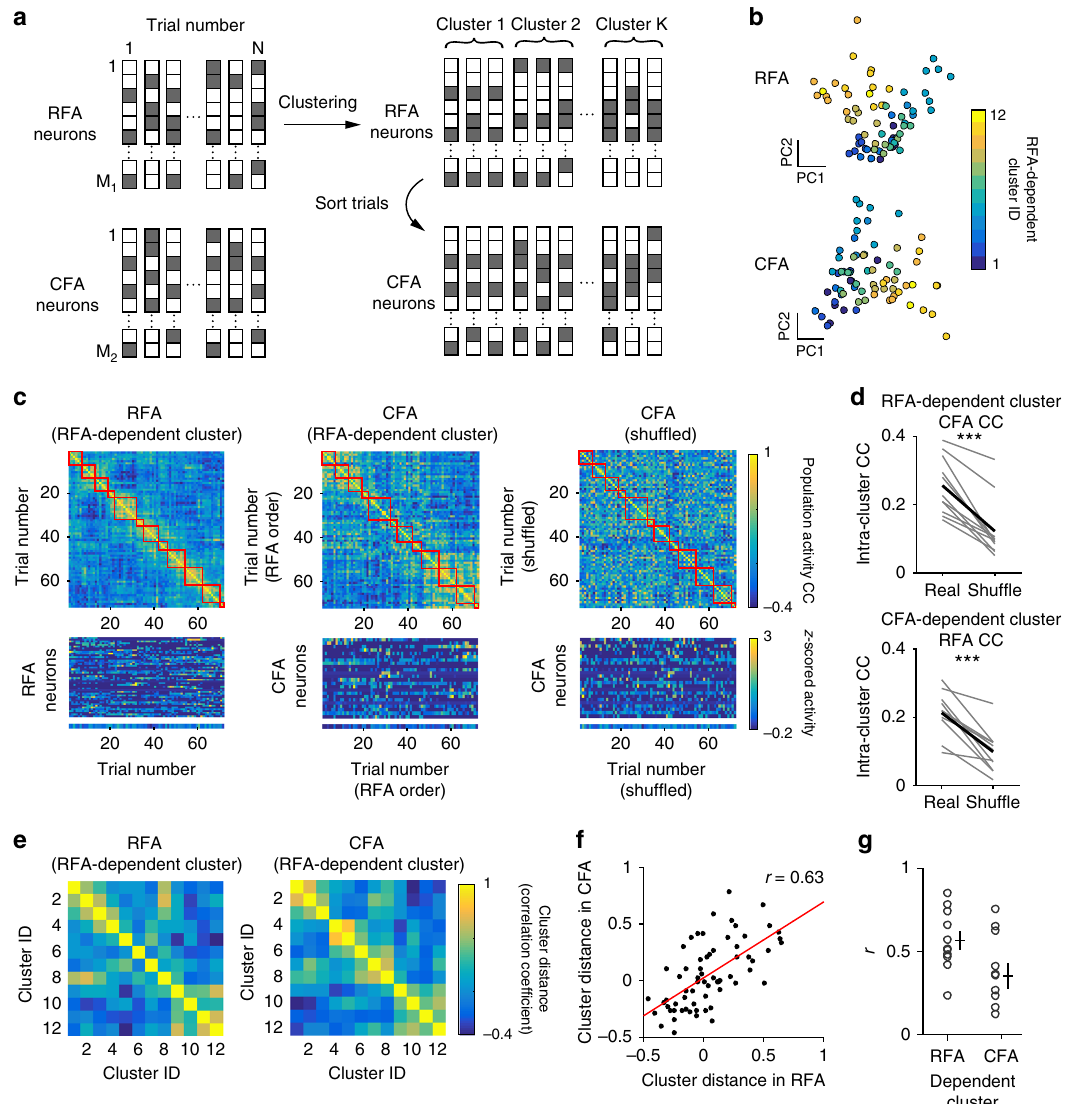
Fig. 8 Relationships in trial-to-trial population activity between RFA and CFA. a Schematic of the analytical procedures. Successful trials were classi fi ed into multiple clusters based on the similarity of the RFA population activity. Then, the similarity of the CFA population activity within each cluster was also estimated. b Scatter plots of the fi rst and second principal components of RFA (top) and CFA (bottom) population activity in each trial in an example imaging session. Face colors indicate the trial cluster numbers assigned from the RFA population activity. We show this plot only for display purpose. c Example correlation coef fi cient matrices in the population activity. In this imaging session, trials were classi fi ed into 12 clusters (red squares) based on the similarity of RFA population activity, and trials were sorted according to the cluster identity of the RFA (left and middle) and randomized order (right). The normalized time-averaged activity of each neuron and the fi eld-averaged fl uorescence changes in each trial are shown at the bottom. Left, matrix made from the RFA population activity. Middle, matrix made from the CFA population activity. Right, matrix made from the trial-shuf fl ed CFA population activity. The imaging session was the same as in b . d Averaged trial-to-trial population activity CC within the clusters (intra-cluster CC). In each fi eld, the CCs between pairs of trials within each cluster were averaged, and these values were averaged across clusters. Gray lines indicate individual pairs and black lines mean values. *** p < 0.001, paired t test ( n = 11). e Example matrices of the distance between intra-cluster-averaged population activity. The imaging session was the same as in b . The distance was de fi ned as the correlation coef fi cient in the averaged population activity between clusters. f Scatter plots of the distances between the same pairs of RFA and CFA clusters shown in e . The red line is a regression line and its correlation coef fi cient ( r ) is also shown. g The correlation coef fi cient ( r ) for the regression line between cluster distance in the RFA and CFA in each imaging session ( n = 11). Crosses indicate mean ±